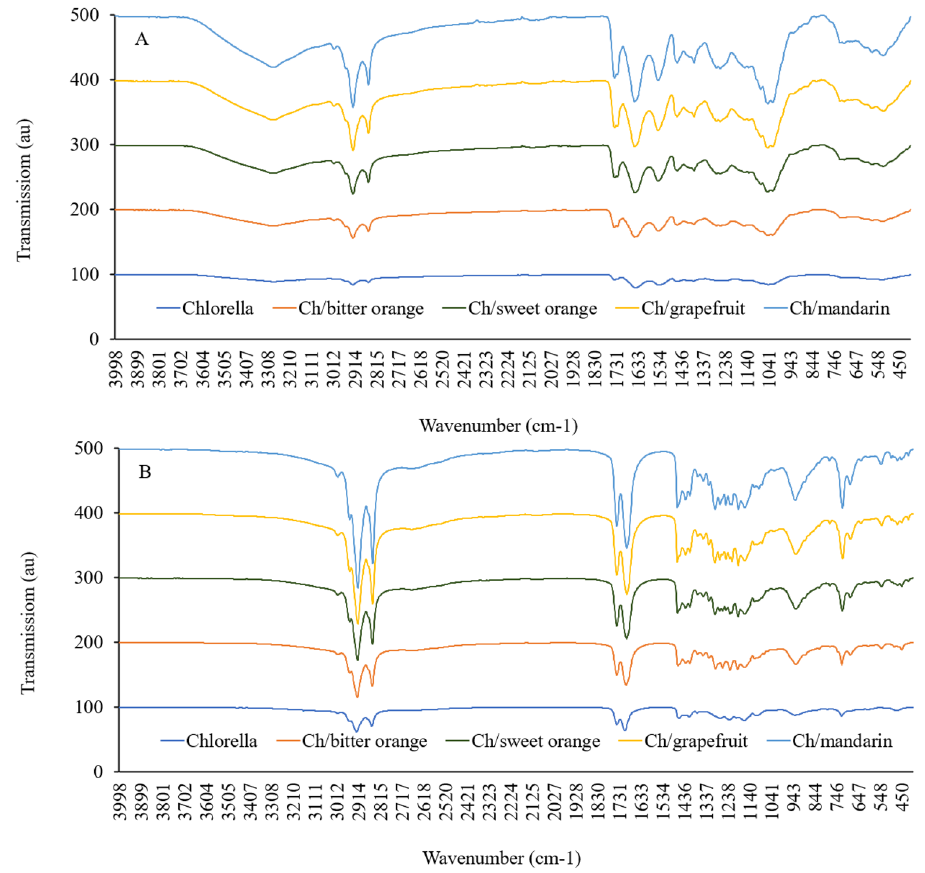
Figure 2. Fourier transform infrared spectrum of whole Chlorella ( A ) and Chlorella fatty acid ( B ) supplemented with fatty acid extract from bitter orange, sweet orange, grapefruit, and mandarin